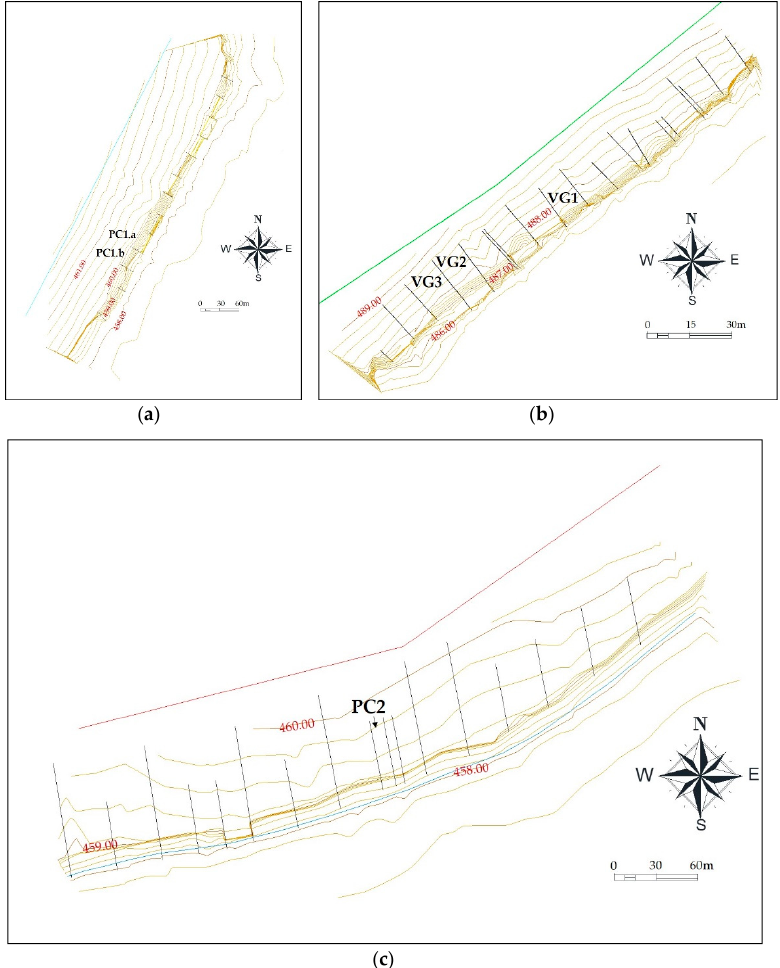
Figure 3. Identification of the sections installed in the HPP experimental units: ( a ) UE1 Porto Colômbia, ( b ) UE Volta Grande, and ( c ) UE2 Porto Colômbia. Table 2. Erosion control techniques evaluated and respective installation sites.